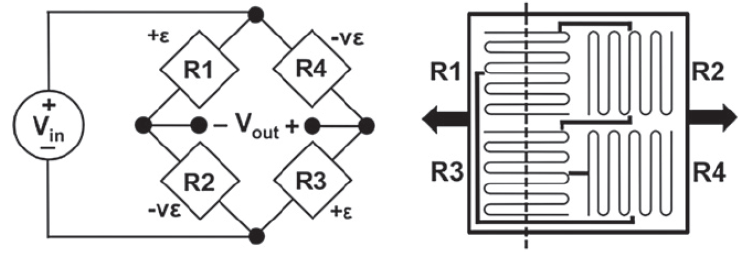
Figure 1. Wheatstone Bridge. The dashed line represents a crack running through the sensor